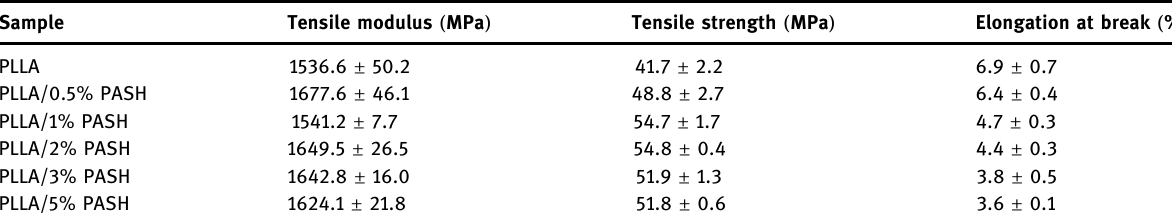
Table 1: The mechanical properties of the virgin PLLA and PLLA/PASH samples